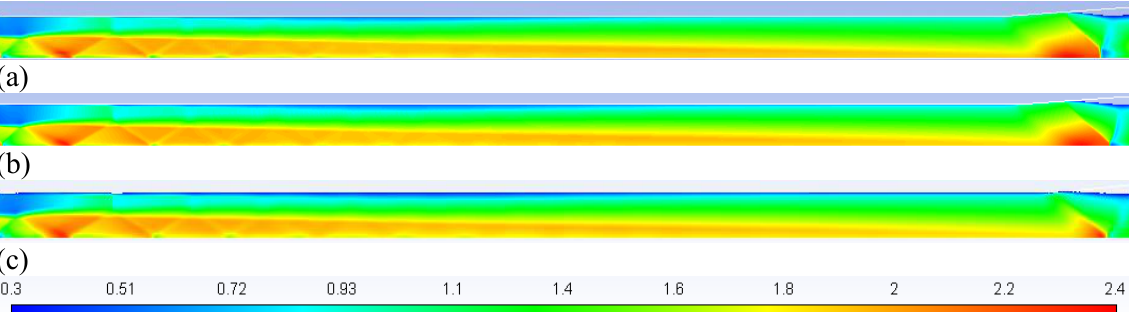
Fig. 7. Mach contours of pressure-based, real gas (a) and density-based, real gas (b) solver and ideal gas Pseudo R32 density- based